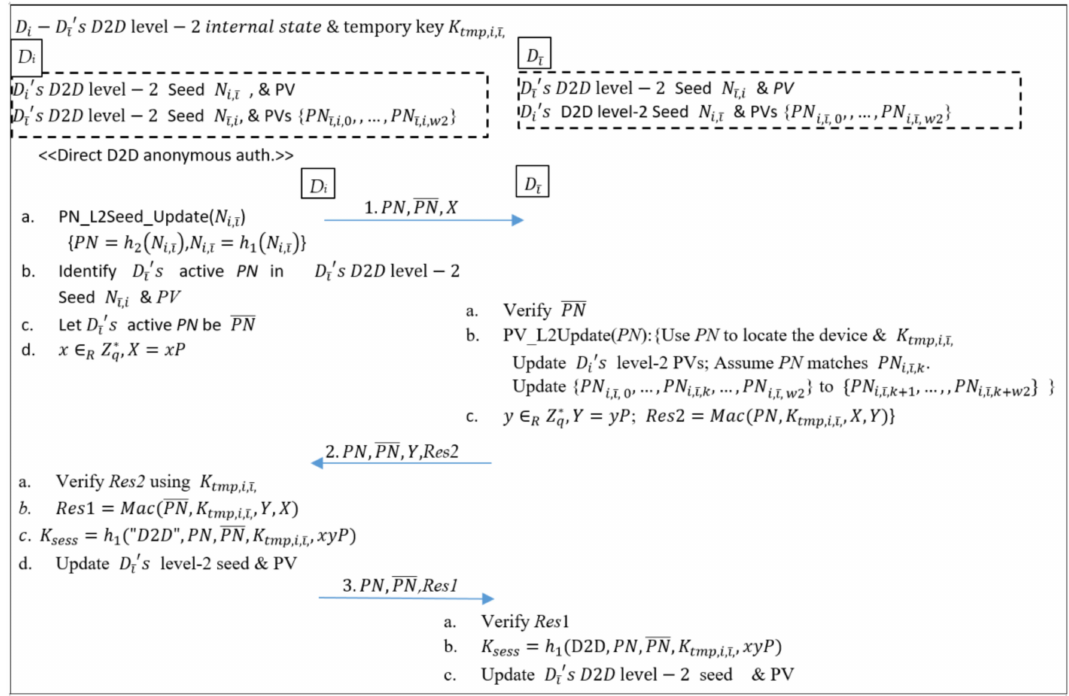
Figure 6. Direct D2D anonymous